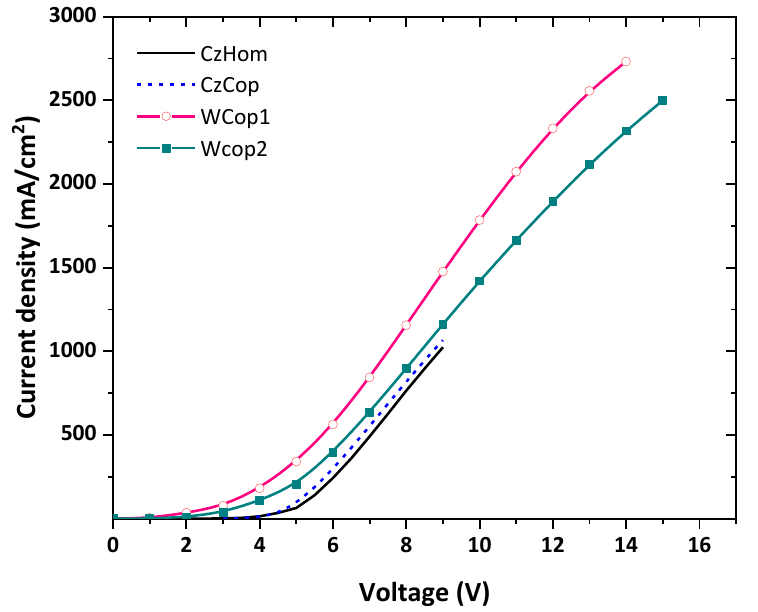
Figure 11. Current density-voltage characteristic curves of CzHom, CzCop and WCop1, WCop2 devices.